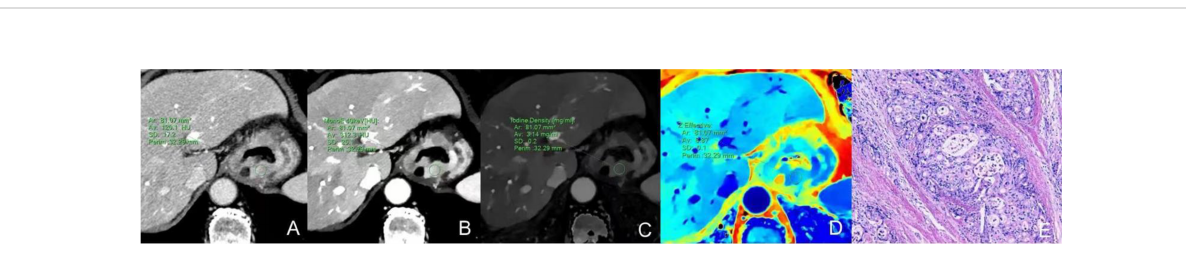
FIGURE 1 Dual-energy CT fi ndings of venous phase AC of the GEJ. A male patient, 68 years old, was con fi rmed with AC of the GEJ by postoperative pathology. (A) Conventional CT image showing irregular thickening of the wall of the GEJ, luminal stenosis, and obvious enhancement in the venous phase. (B) 40 keV virtual monochromatic image showing a CT attenuation value of the lesion in the venous phase of 312.3 HU. (C) The IC of the solid component of the lesion was3.14 mg/ml. (D) The Z eff of the lesion was 8.87. (E) Hematoxylin-eosin staining of AC with ×100 magni fi cation.